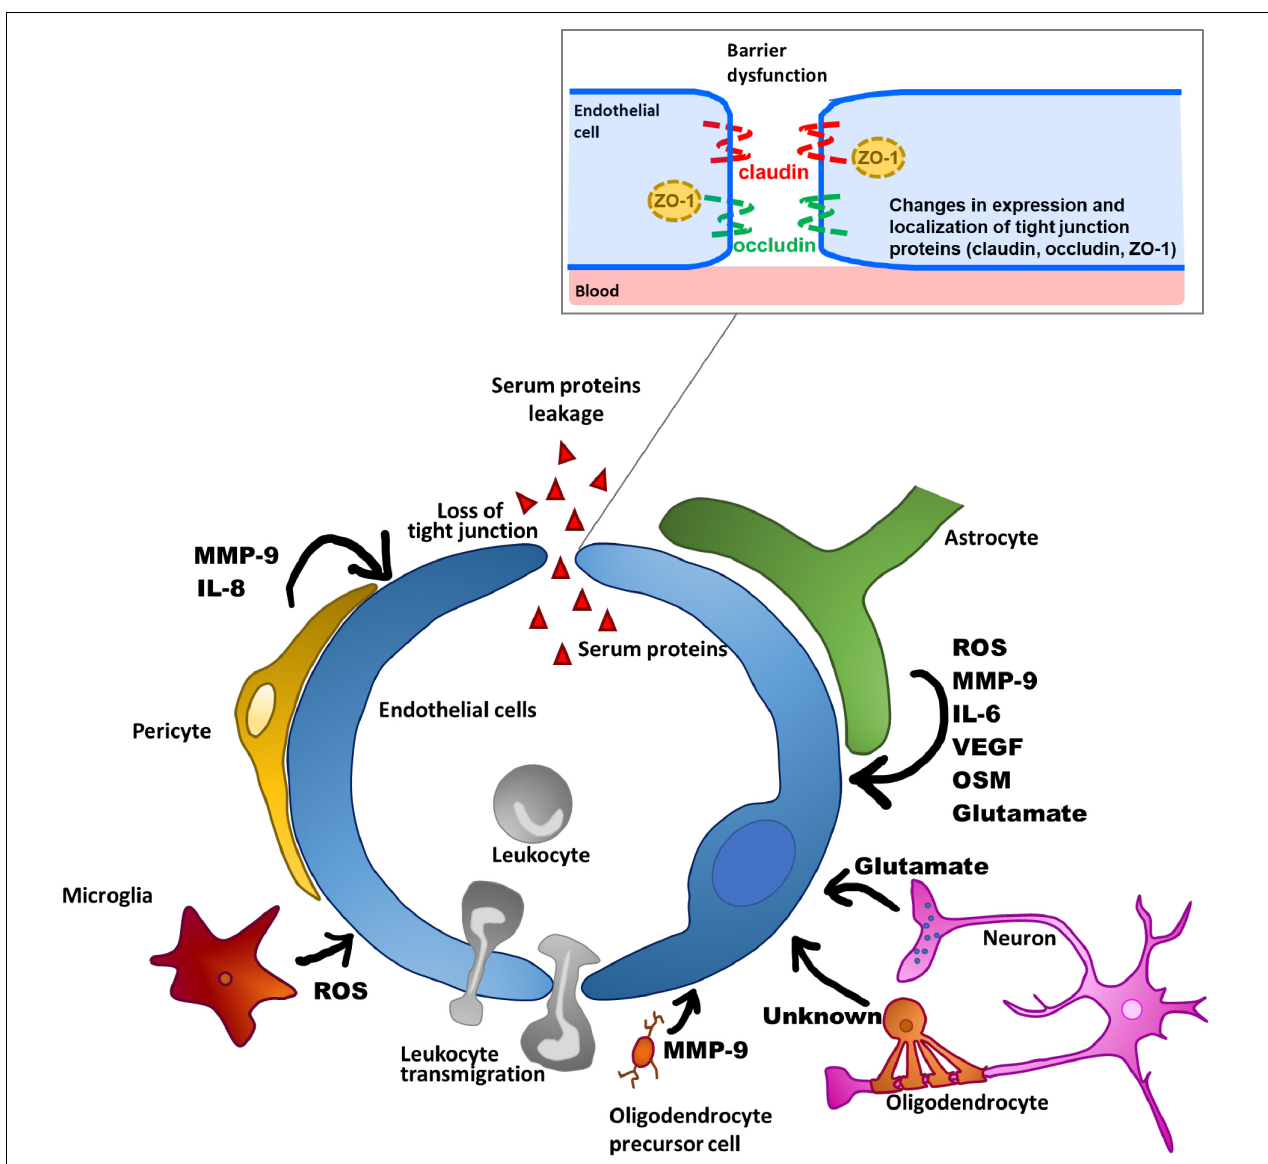
FIGURE 2 | Schematic overview of BBB dysfunctions through factors produced by NVU-constituting cell types.